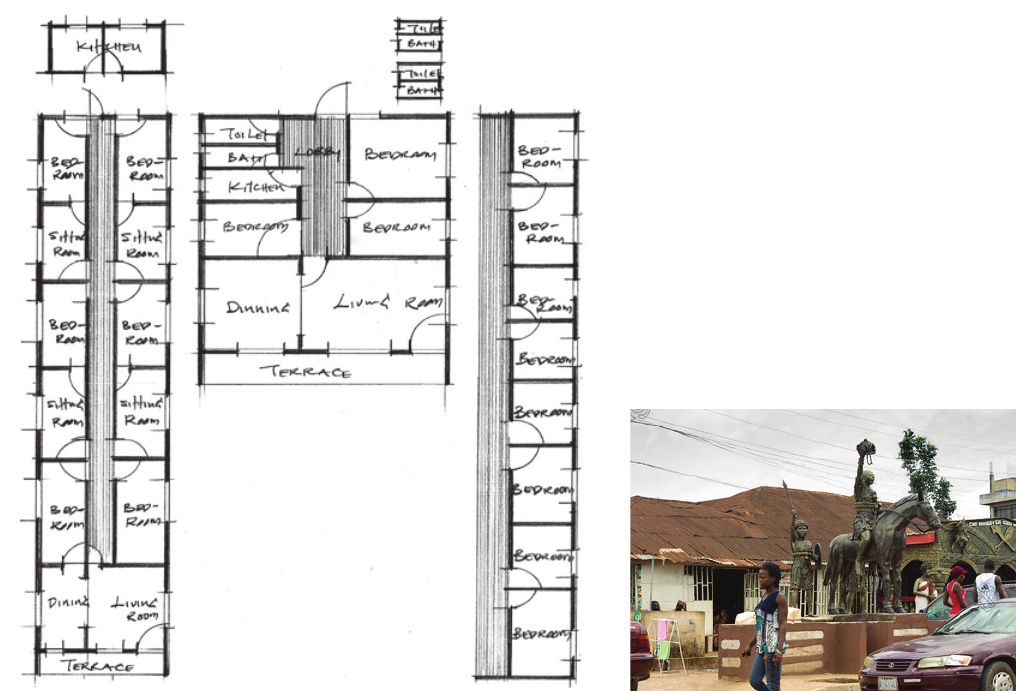
Fig. 7. Floor plan and picture of a typical hybrid family-compound Benin house Source: Ekhaese (2011).